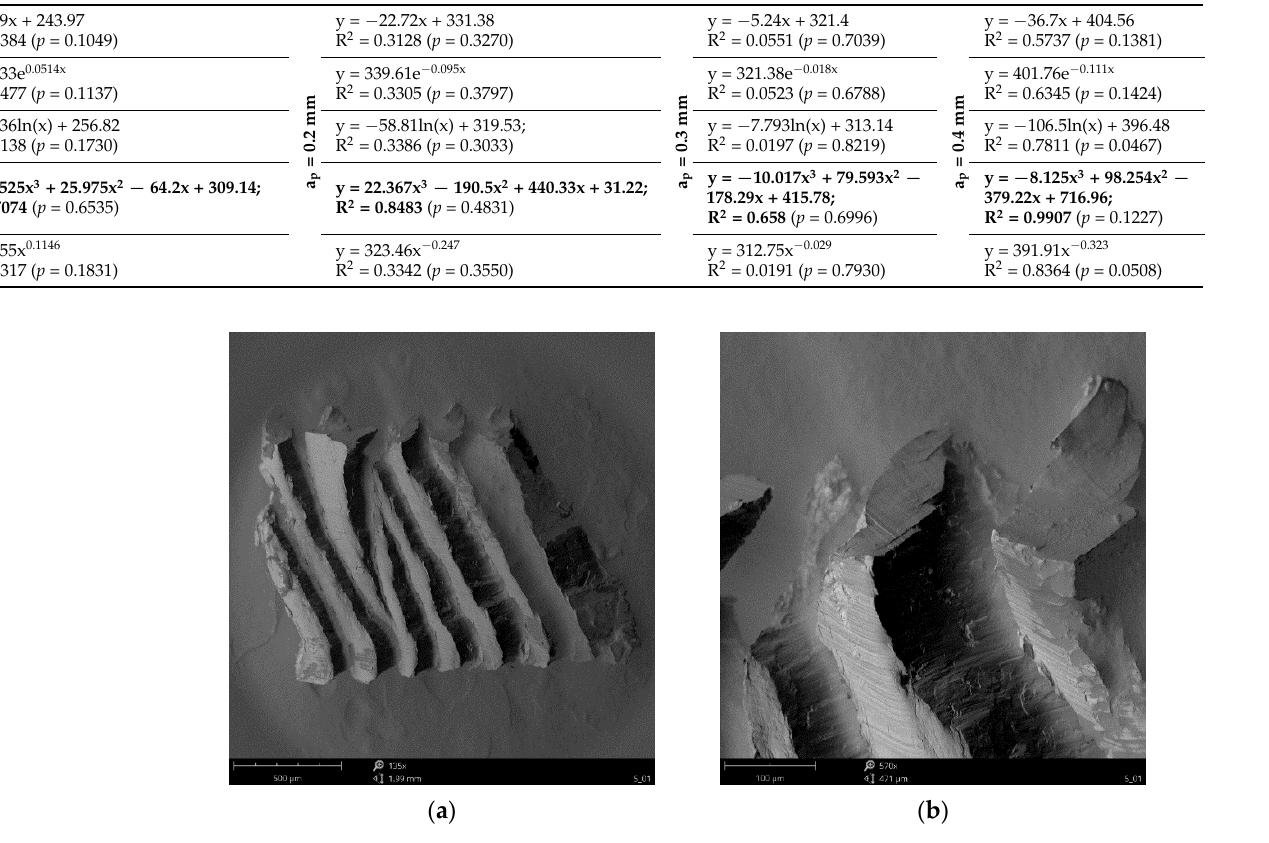
Figure 12. SEM imaging of a magnesium alloy chip surface from the chip flow side on the rake face ( a ) cracks and ( b ) tearing on the free